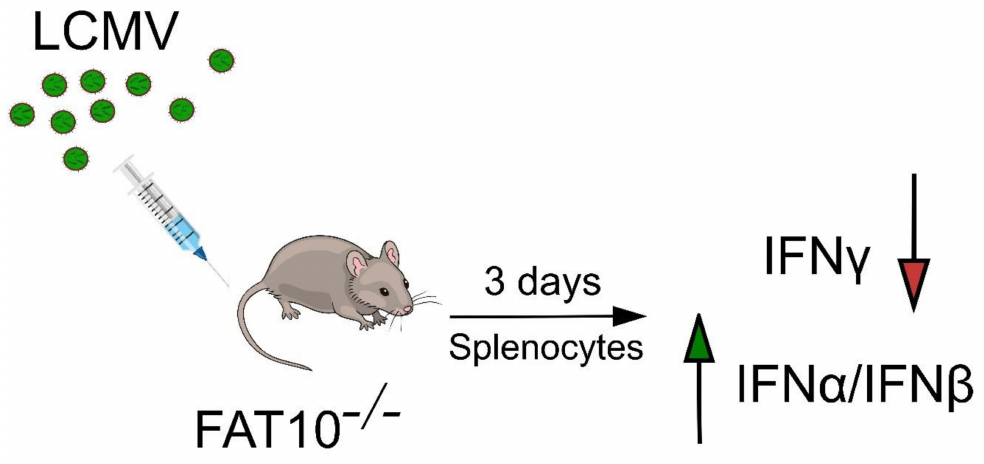
Figure 1. HLA-F adjacent transcript 10 (FAT10) balances the interferon response in vivo. FAT10-deficient mice display an altered interferon response 3 days after infection with lymphocytic choriomeningitis virus (LCMV). Splenocytes from LCMV-infected FAT10 - / - mice show a reduced production of IFN- γ and an enhanced production of IFN α / β , indicating that FAT10 expression induced by viral infection enhances the type II interferon response while it attenuates the type I interferon response. The latter e ff ect may limit inflammation and tissue damage in infected